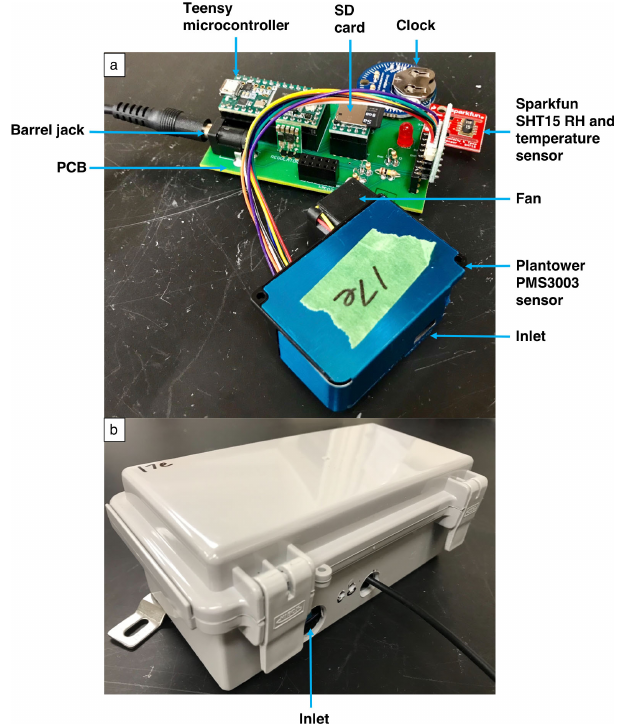
Figure 1. (a) The custom-designed printed circuit board (PCB) and its components for the Plantower PMS3003 sensor packages. (b) Electrical box housing all components for outdoor